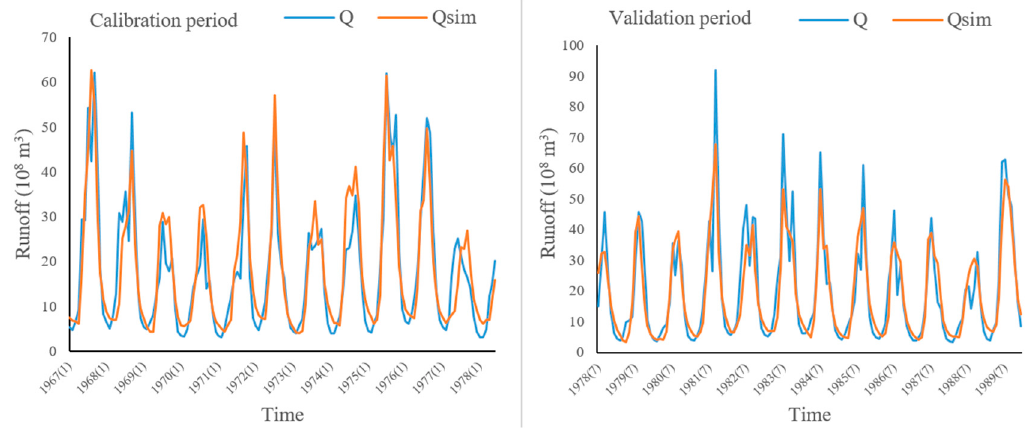
Figure 6. Monthly runoff simulation results in the pre ‐ change period using the monthly ABCD model.